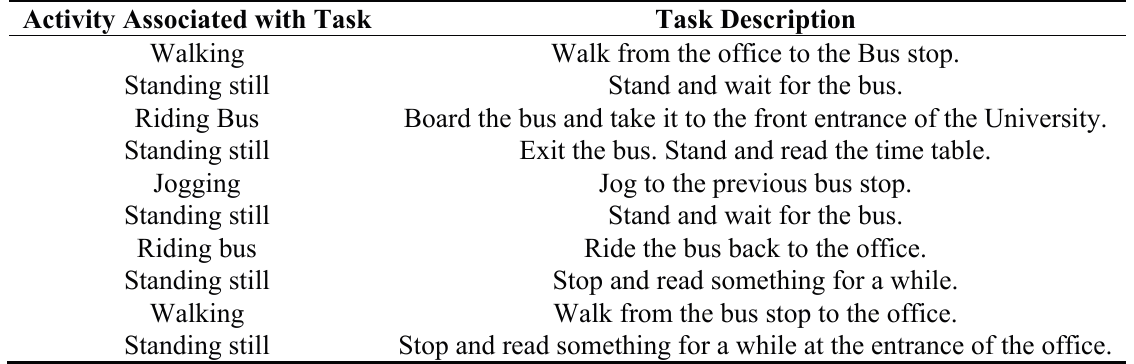
Table 2. Activities completed during the Semi-structured experimental protocol (Task 2). Activity Associated with